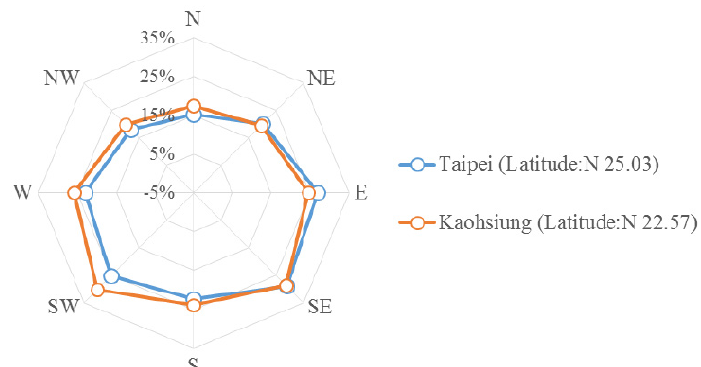
Figure 11. Cooling energy saving rate of every direction.